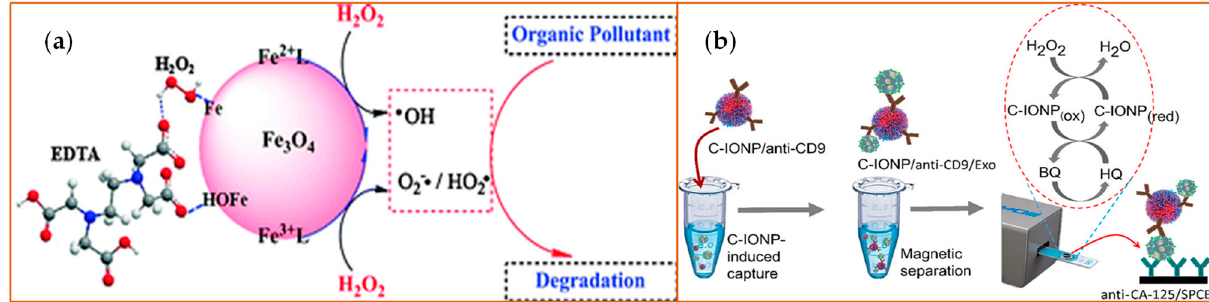
Figure 2. Examples of iron (Fe)-based metal oxide nanozymes. The figure depicts catalysis reactions of H 2 O 2 decomposition reaction with Fe 3 O 4 or Fe 2 O 3 [40] NPs. ( a ) The Fe 3 O 4 NPs bear active H 2 O 2 on their surface that generate ROS and, therefore, increase the degradation rates of organic pollutants such as pentachlorophenol, sulfamonomethoxine, and Rhodamine B (RhB). EDTA: Ethylenediaminetetraacetic acid. Reprinted with permission from ref. [41]. Copyright 2010 Royal Society of Chemistry; ( b ) The peroxidase-mimicking activity of the carboxyl group-functionalized iron oxide nanoparticles (C-IONPs) displayed the ability to catalyze the oxidation of TMB in the presence of H 2 O 2 for the direct isolation and quantification of disease-specific exosomes, as the authors demonstrated using exosomes bearing the ovarian cancer biomarker (CA ‐ 125). Exo: exosomes; SPCEs: screen ‐ printed carbon electrodes; HQ: hydroquinone; BQ: